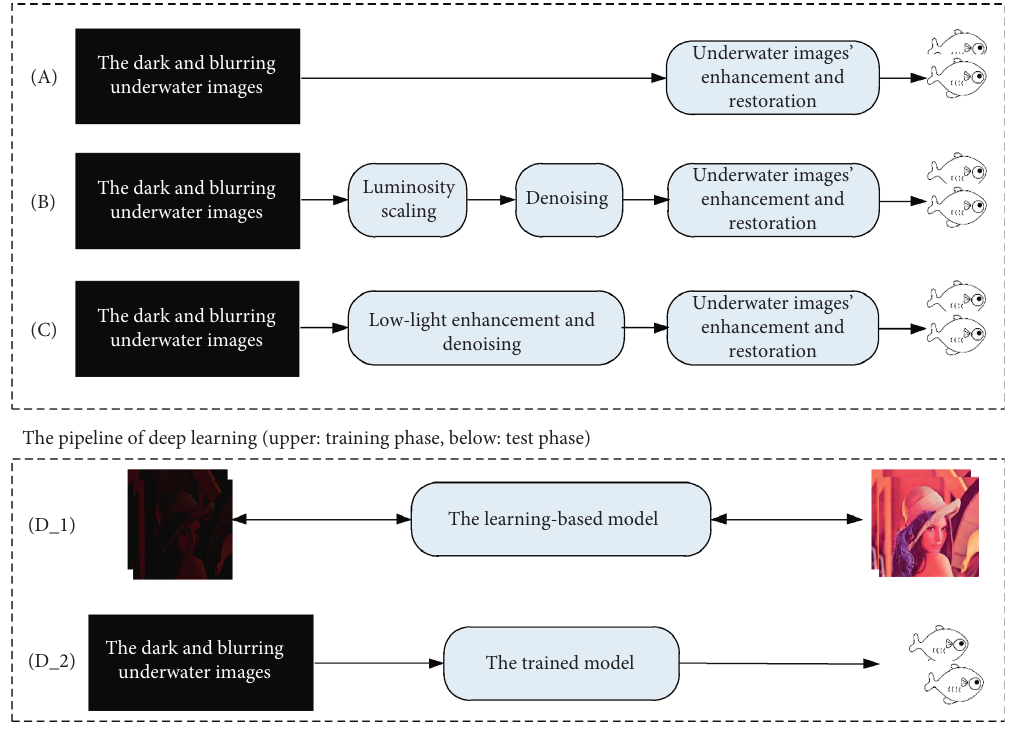
Figure 3: The pipelines are based on traditional methods and deep learning. The input test images are taken in dark and blurred water. The goal of the algorithm is to generate the respective high-quality clear images. The top subimage surrounded by the dotted box represents traditional methods, including the pipeline only using an underwater image enhance/restoration algorithm (line A) and the cascade algorithms (line B and line C). The bottom subimage represents an end-to-end algorithm based on deep learning including the training phase (line D_1) and the test phase (line D_2).